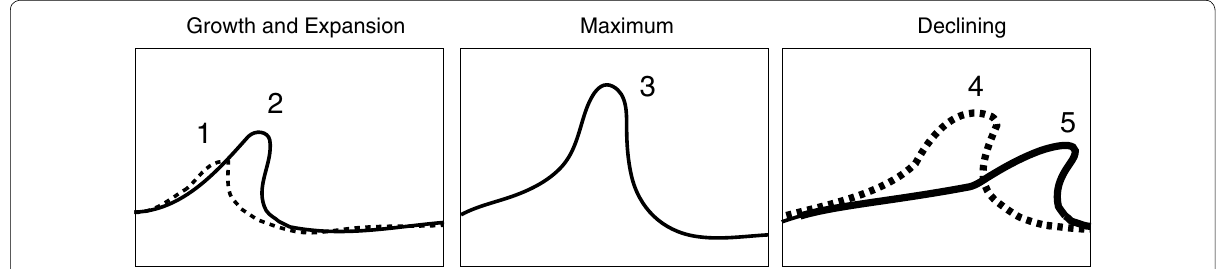
Fig. 8 Schematic depictions of the dynamic signatures of omega band auroras from the growth and expansion period to the declining period through the maximum